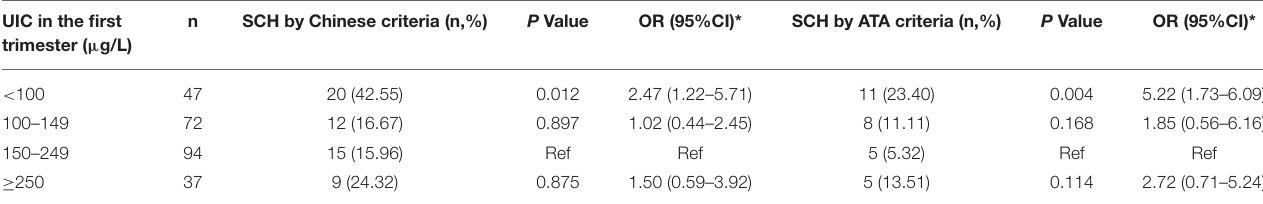
TABLE 5 | Multivariable logistic regression analyses of association between urinary iodine concentrations in the first trimester and incidence of subclinical hypothyroidism in second and third trimesters among pregnant women by Chinese and ATA diagnostic criteria. UIC in the first n SCH by Chinese criteria trimester ( µ g/L)